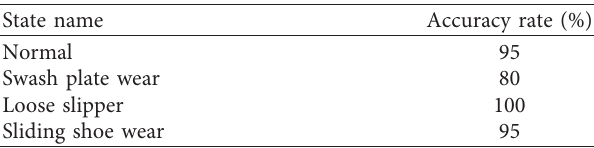
Table 7: Classification accuracy rate of EMD combined with en- ergy feature